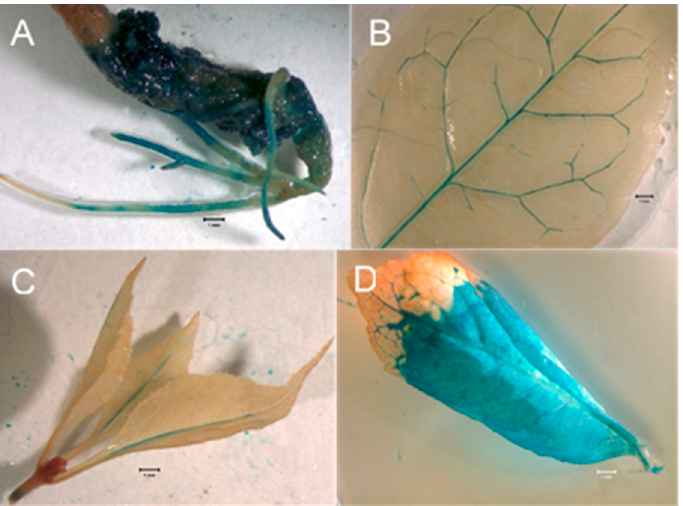
Figure 3. GUS expression assays in regenerated ash somatic seedlings. ( A ). Hypocotyl and roots of a germinated transgenic ash somatic embryo showing GUS expression. Bar = 1 mm. ( B ). Leaf from transgenic ash somatic seedling showing GUS expression in vascular tissues. Bar = 1 mm. ( C ). Shoot tip with leaves from transgenic ash somatic seedling showing GUS expression in shoot tissue and mid-veins of leaves. Bar = 1 mm. ( D ). Leaf from transgenic ash somatic seedling showing GUS expression in both veins and interveinal tissue. Bar = 1 mm.